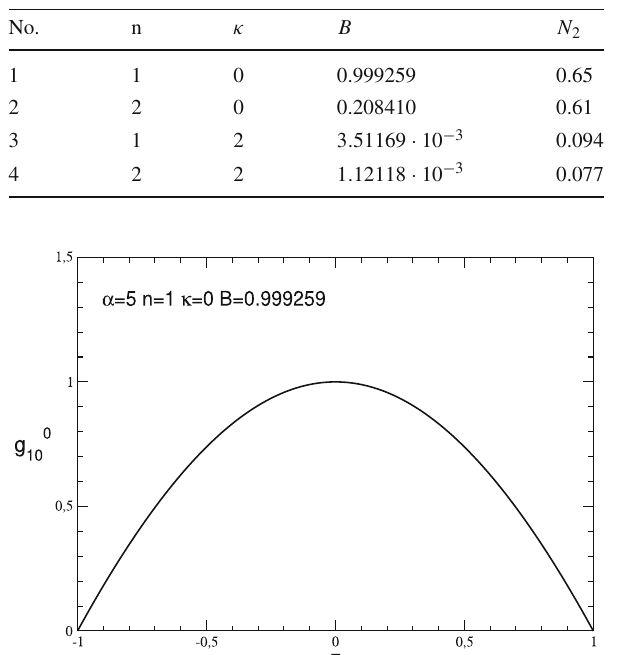
Fig. 3 g 0 for the normal state No. 1 of Table 1 10